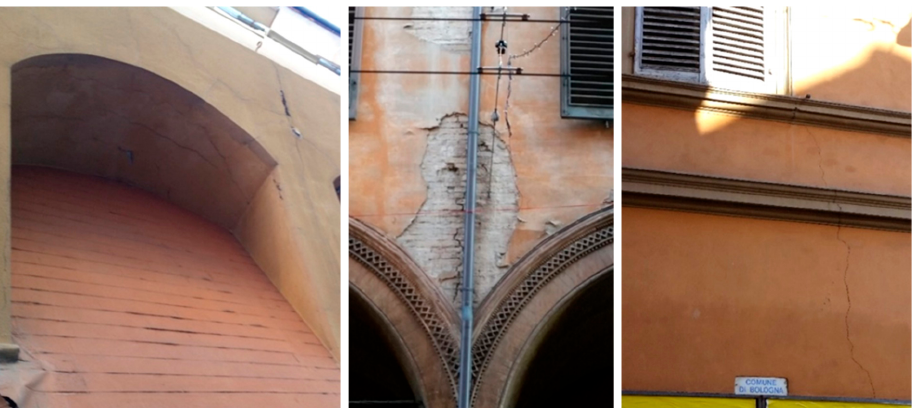
Figure 13. Typical cracking patterns due to gravity loads and lack of tension resistance and load distribution, Bologna, Italy. Composite reinforcing systems can be installed all over the surface of the arch or vault extrados/intrados or implemented in discrete stripes. Although the extrados stripes installation needs floor and backfill removal, requiring more time and cost, it preserves intrados decorative paintings and provides a better connection between the substrate and the composite due to curvature. After the substrate preparation and cleaning, the first mortar layer is spread, and the fabric strip is placed by pushing on the mortar until the mortar comes out of the fibers spaces. Then, the second mortar layer is spread to cover the fabric strip adequately, and finally, a transverse fabric strip with primer and mortar is implemented to complete the reinforcing system. The strengthening application on the extrados of the arch/vault is a very efficient solution since no hinges are allowed to form on the strengthened surface side. Hence, the new collapse mechanism will activate with a greater load multiplier than the un-strengthened one. Figure 14 shows the reinforcement of the masonry vault with extrados composite strips [64].